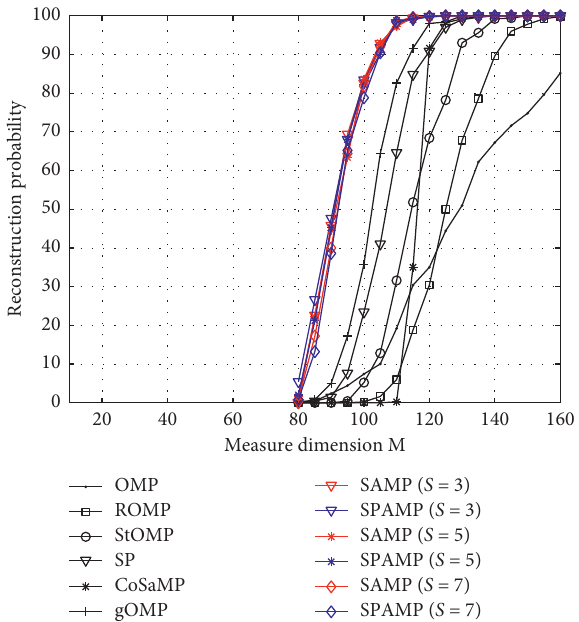
Figure 7: Probability of exact recovery versus the observation dimension ( K � 40).